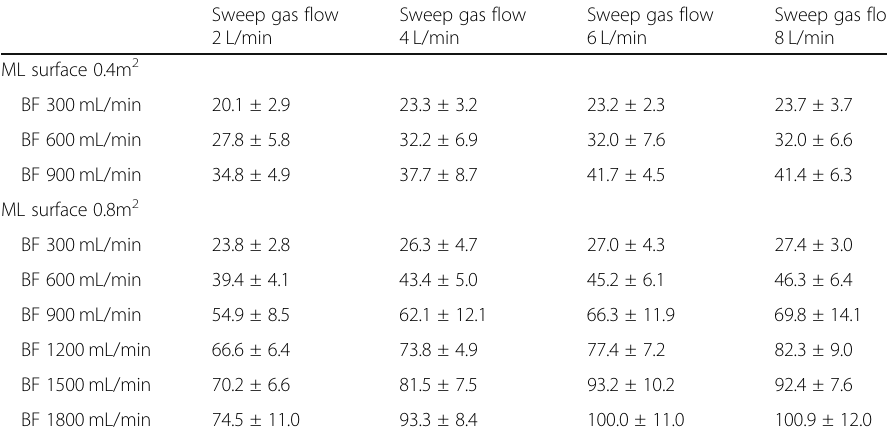
Table 1 Normalized extracorporeal CO 2 elimination (absolute values are given in millilitre per minute). Normalized CO 2 elimination was calculated by normalizing the partial pressure of carbon dioxide before the membrane lung to 45 mmHg. Values are given as mean with standard deviation Sweep gas flow 2